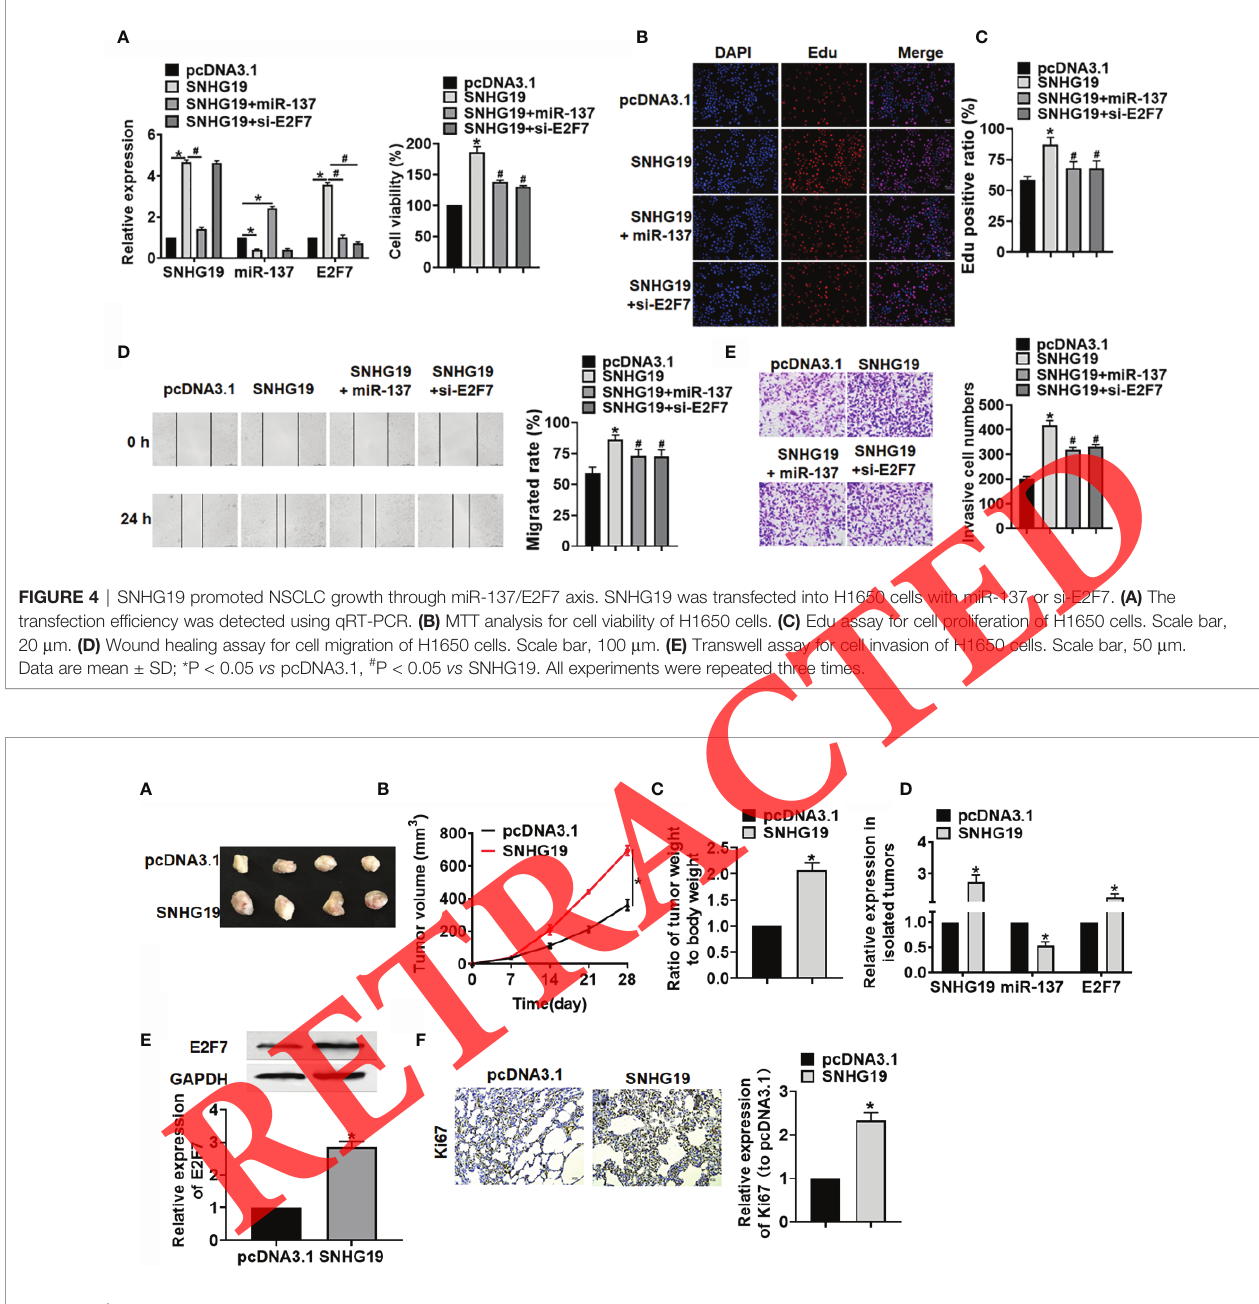
FIGURE 5 | SNHG19 promoted NSCLC growth in vivo . 30 mice were divided into two groups randomly, H1650 cells were subcutaneously injected into nude mice. And lentivirus packaged SNHG19 or pcDNA3.1 was injected through the tail vein. (A) Tumors were isolated after injection of H1650 cells. (B) Tumor volume was measured every 7 days. (C) The ratio of tumor weigh to body weight was calculated. (D) The mRNA of SNHG19, miR-137, and E2F7 in isolated tumors was detected by qRT-PCR. (E) The protein level of E2F7 in isolated tumors. (F) Ki67 staining was used to detect proliferation of isolated tumors. Data are mean ± SD; *P < 0.05. All experiments were repeated three